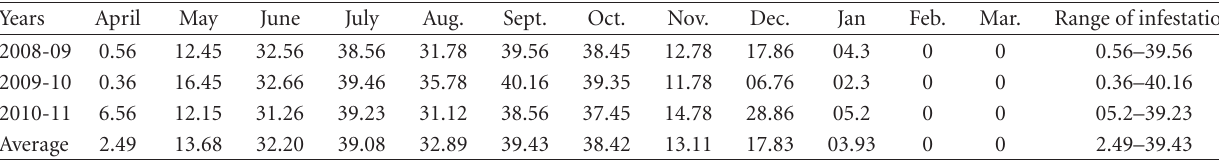
Table 1: Leaf roller infestation during di ff erent months (percentage).